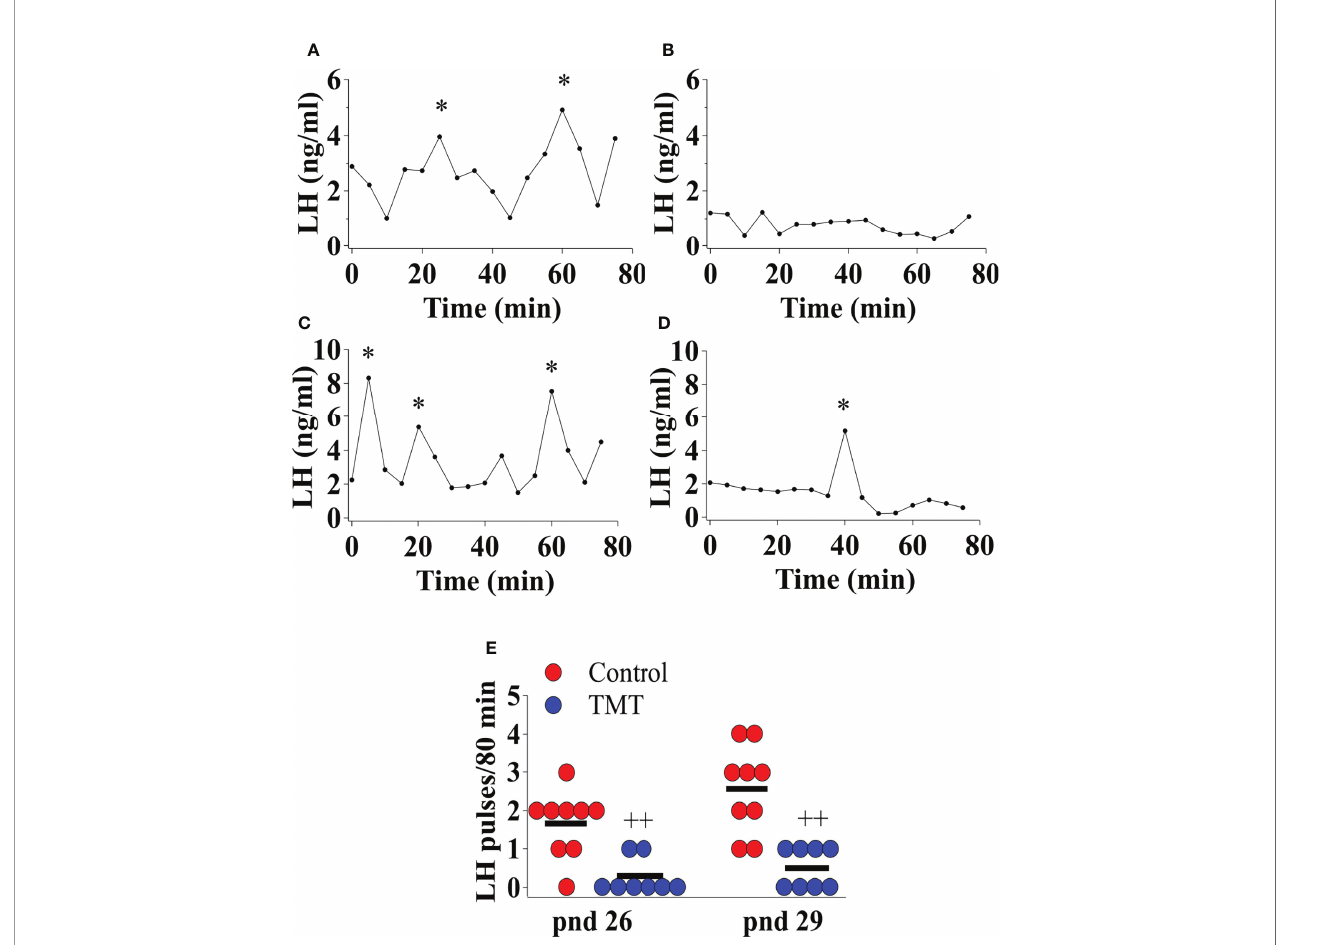
FIGURE 4 | Female C57Bl6/J mice chronically exposed to 2,4,5-Trimethylthiazole (TMT) from post-natal day (pnd) 21 for 14 days showed suppressed pre-pubertal pulsatile luteinising hormone (LH) secretion on pnd 26 and 29. Representative LH pulse pro fi le with (A) control mouse on pnd 26, (B) TMT-exposed mouse on pnd 26, (C) control mouse on pnd 29 and (D) TMT-exposed mouse on pnd 29. (E) , Summary of LH pulse frequency on pnd 26 and 29 of control and TMT-exposed group during the 80 min blood sampling period. LH pulses detected by the DynePeak algorithm are indicated with an asterisk * located above each pulse on the representative LH pulse pro fi les. F (1,15) =17.00, ++p<0.001; F (1,15) =21.96, ++p<0.001 control group (combined water control: n=6; ethyl vanillin control: n=3) vs. TMT- exposed group (n=8) on pnd 26 and 29,